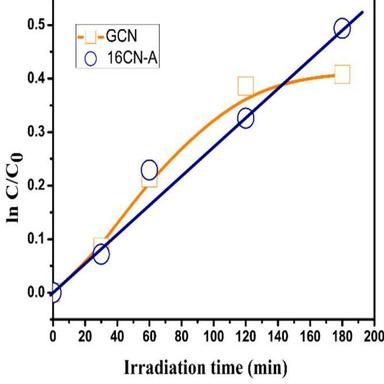
A plot of ln Vs irradiation time: (O)-16CN-A; (□)- of g-C3N4.